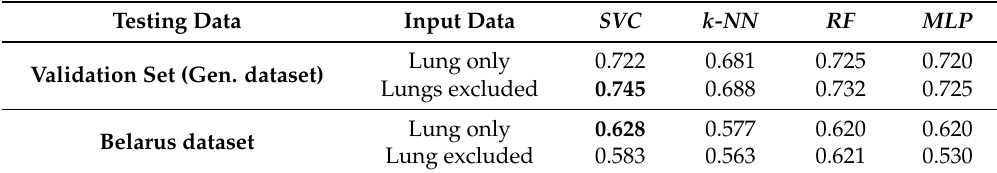
Table 4. AUC Performance with radiomic